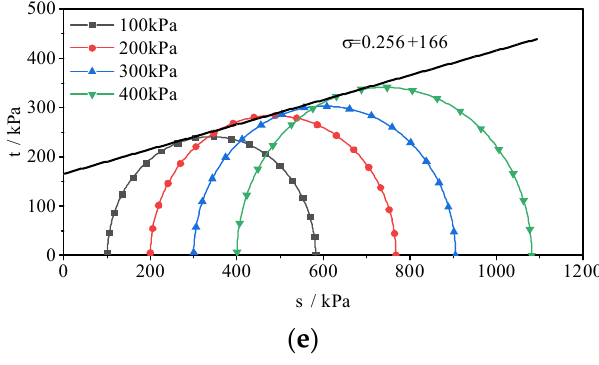
Figure 6. Mohr stress circle of SCSC. ( a ) SCSC0 ( b ) SCSC4 ( c ) SCSC6 ( d ) SCSC8 ( e ) SCSC10. Table 4. Friction angle and cohesion of SCSC.